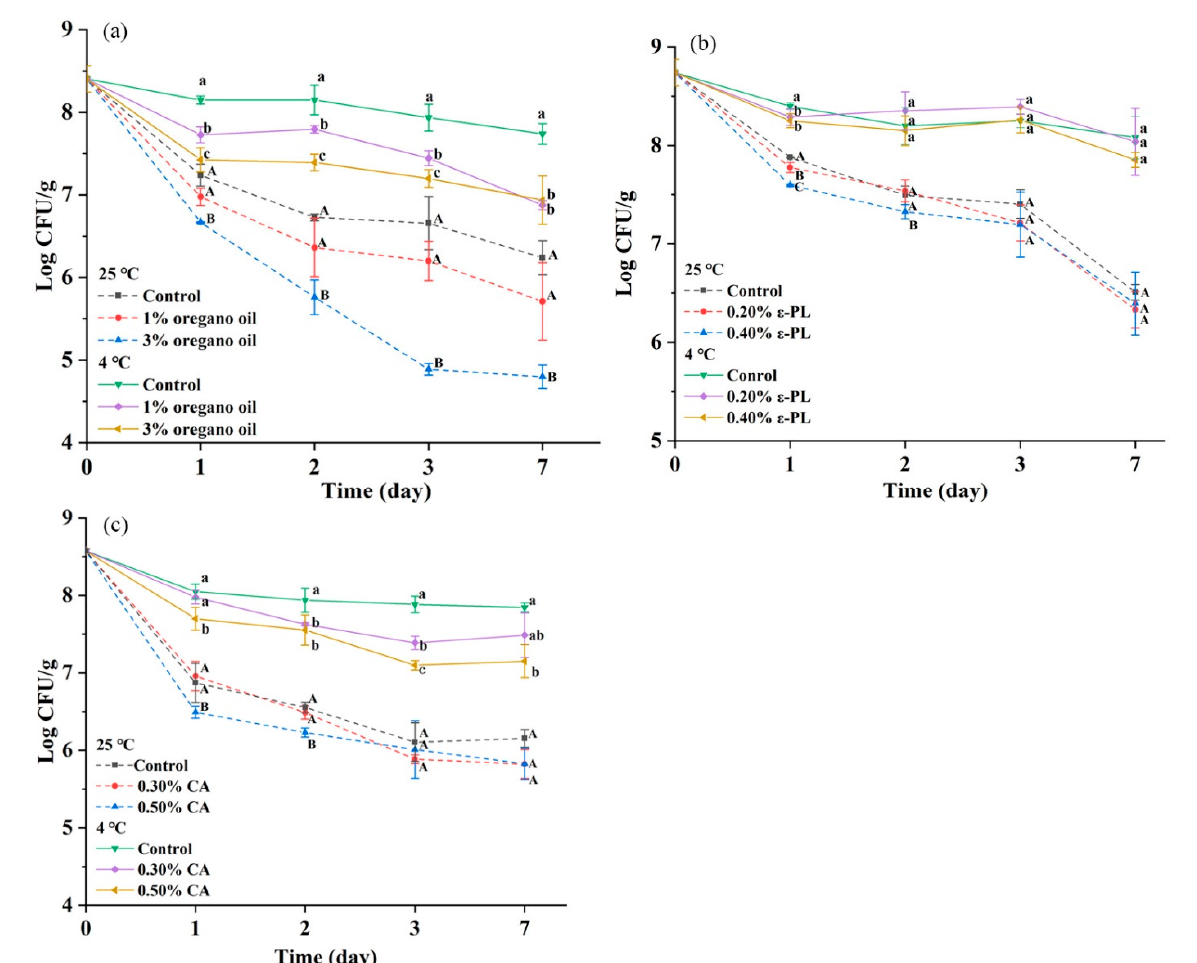
Figure 4. Antimicrobial activity of oregano oil ( a ), ε -PL ( b ) and CA ( c ) against S. montevideo CICC 21588 in undiluted tahini at 25 °C or 4 °C. The same lower case letter among different treated samples at each day during 4 °C storage indicates mean values are not significantly different ( p > 0.05). The same uppercase letter among different treated samples at each day during 25 °C storage indicates values are not significantly different ( p > 0.05).